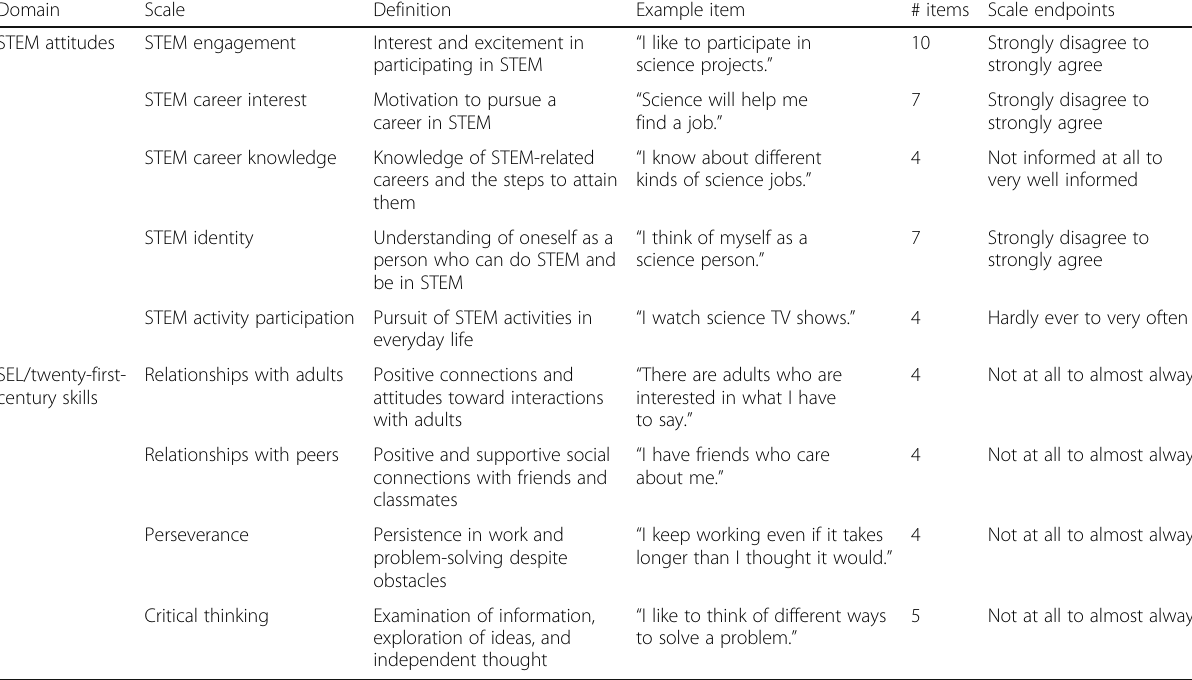
Table 2 Domains, scales, definitions, and item examples for the common instrument suite — student survey